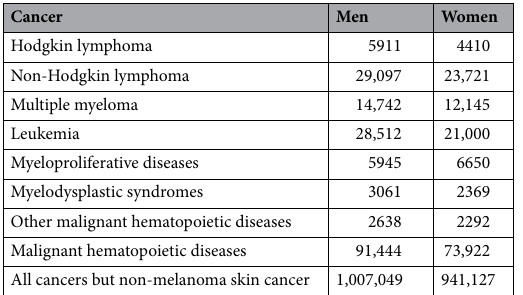
Table 1. Hematopoietic neoplasms and all cancers in Sweden